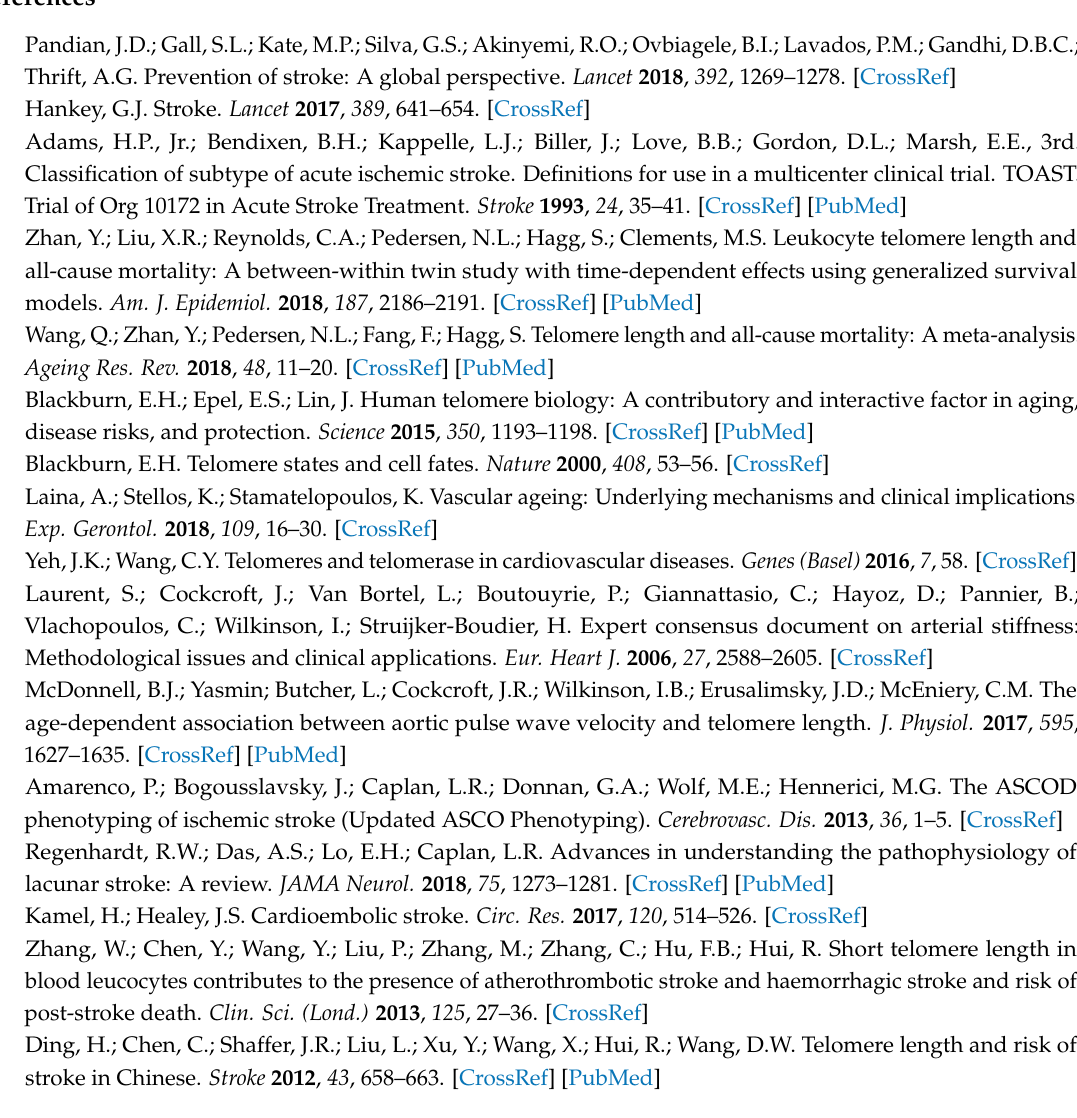
Figure S1: Sensitivity analysis for the associations of genetically predicted TL with ischemic stroke and its subtypes; Table S1: Approximate detectable odds ratio (OR) per one standard deviation of telomere